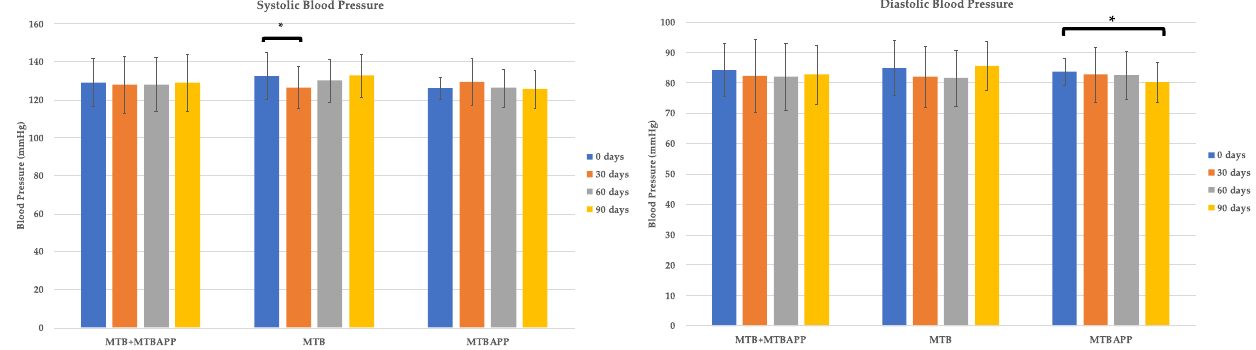
Figure 3. Blood pressure analysis MTB vs. MTBAPP. * p < 0.05 by intragroup analysis SBP = systolic blood pressure, and DBP = diastolic blood pressure. blood pressure, and DBP = diastolic blood